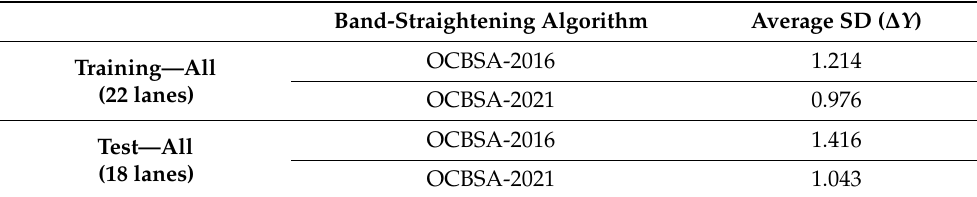
Table 1. The average SD of the deformation introduced to the lanes without bands after processing with OCBSA-2016 or OCBSA-2021, for the training and test